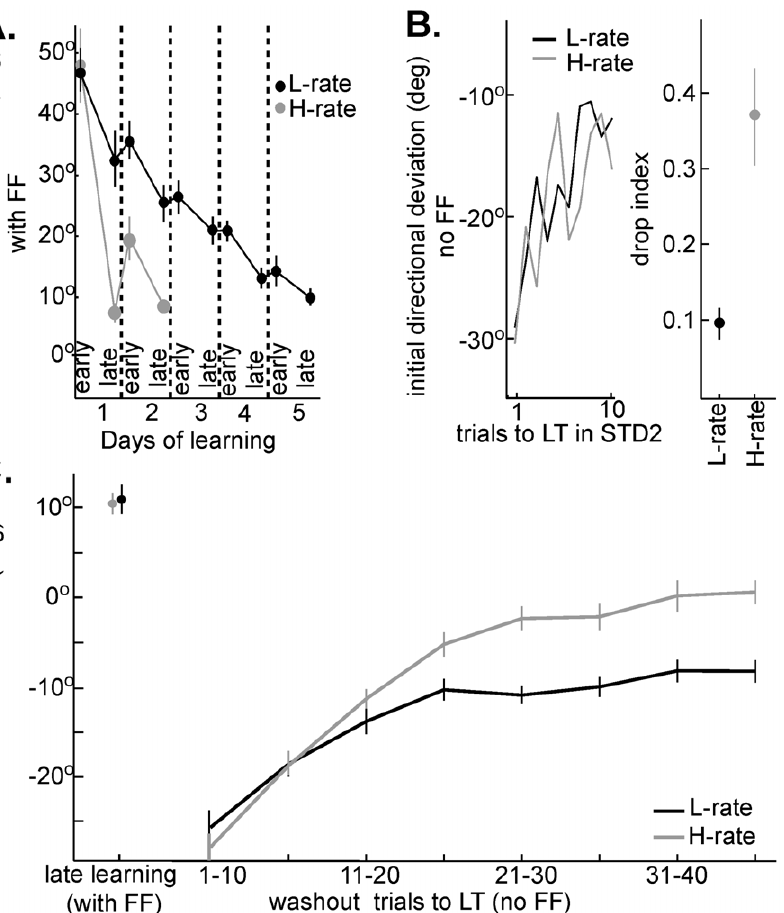
Figure 3. Learning under high rate practice schedule (H-rate) is more labile to interference than learning under the low rate (L-rate). Performance in all plots is measured by the initial directional deviations of the hand. (A) Effect of the overnight pause : Performance on the first and the last 5 force-field trials in each learning day (L-rate: days 1-5 in black, H-rate: days 1–2 in grey). In the L-rate performance gradually improves over the days with almost no overnight drops between consecutive learning days, whereas under the H-rate it shows a significant overnight drop (t- test, p , 0.01) between the first (10 u ) and second day (20 u ). (B) Effect of the standard epoch (STD2): The plots show the aftereffects of learning on standard trials in STD2 (left) and the effect of these trials on the subsequent continuation of learning (right plot). The left plot shows that the aftereffects gradually decreased in both the L-rate (black) and the H-rate (grey). However, the right plot shows that the drop in performance between force-field trials before and after STD2 (right) was significantly larger under the H-rate than the L-rate (t-test, p , 0.01). (C) Effect of washout : Performance without force-field (aftereffects) after learning under L-rate practice schedule (black) was washed out less than performance after learning under H-rate (grey), which was washed out completely. The figure shows that performance on the last 10 force-field trials of the L-rate and H-rate learning sets were similar ( , 10 u , ANOVA p . 0.5) and resulted in similar aftereffects when switching to standard trials ( , 2 25 u , ANOVA p . 0.5). The aftereffects gradually decreased (less negative values in the plot), but from trial 15 until the end of washout the aftereffects in the L-rate were larger than in the H-rate. The aftereffects in the last 10 trials of the washout were significantly different from zero in the L-rate (t-test, p , 0.01) but not in the H-rate (t-test, p .